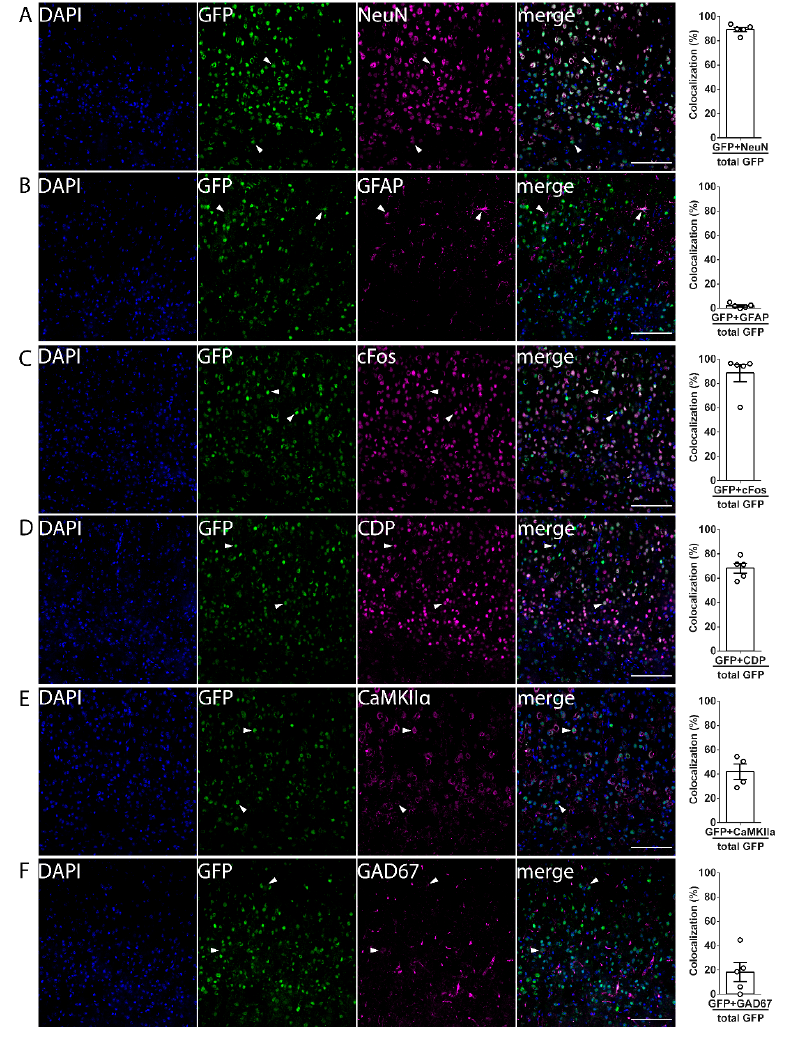
Figure 2. The colocalization patterns of mPAK3 ‐ GFP proteins in the cortical layers of dTg animals. ( A – E ) The individual and merged immunostaining images of DAPI (blue), GFP (green), and RFP (magenta) in coronal cortical sections of adult dTg mice. Cells expressing mPAK3-GFP proteins in the cortex colocalized with ( A ) neuronal NeuN (89.41 ± 1.831%), ( C ) immediate-early gene cFos (88.64 ± 7.073%), ( D ) layer 2/3 CDP (68.32 ± 3.910%), ( E ) excitatory neuronal CaMKII α (41.85 ± 6.265%), and ( F ) inhibitory GAD67 (18.21 ± 7.718%), but rarely with ( B ) astrocytic GFAP (2.065 ± 0.8473%). Percentages represent cells with colocalization over total mPAK3-GFP cells. Scale bars = 100 µ m. NeuN n = 5, GFAP n = 5, cFos n = 5, CDP n = 5, CaMKII α n = 4, GAD67 n = 5. White arrows indicate sample mPAK3-GFP-expressing cells with and without colocalization in all images. dTg, double transgenic; GFP, green-fluorescent protein; RFP, red-fluorescent protein; DAPI, 4 (cid:48) ,6- diamidino-2-phenylindole; GFAP, glial fibrillary acidic protein; CDP, CCAAT-displacement protein; CaMKII α , calcium/calmodulin-dependent protein kinase II alpha; GAD67, glutamate decarboxylase 67. Data are expressed as mean ± SEM. n = number of